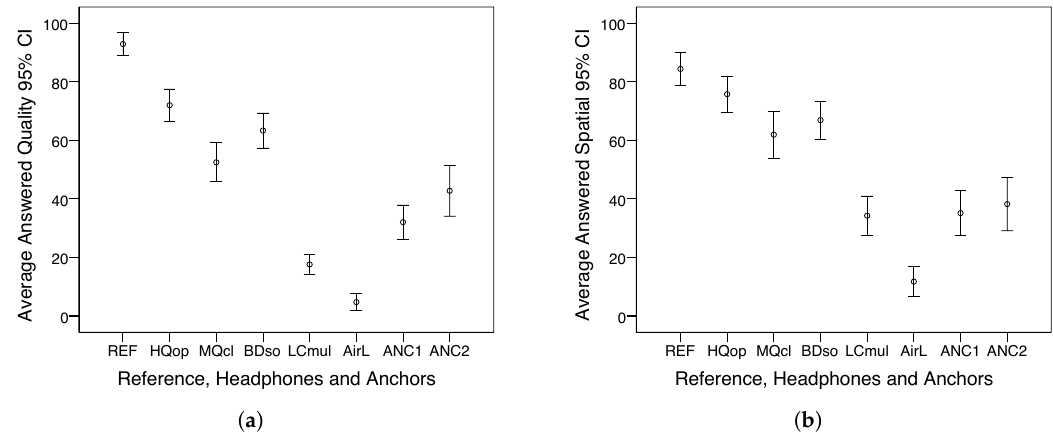
Figure 7. ( a ) Average answered quality versus reference, headphones and anchors (minutes); ( b ) average answered spatial impression versus reference, headphones and